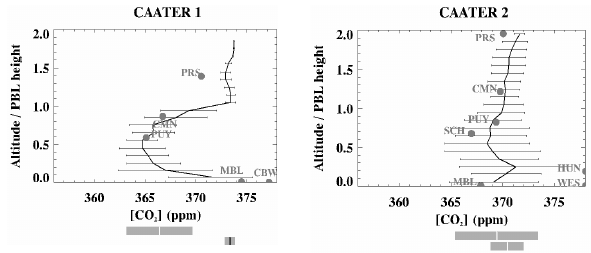
Fig. 11. Variability observed in the PBL and the FT during each campaigns (left: CAATER 1, right: CAATER 2) using profiles only. The altitude of each individual profile has been normalized to the relevant PBL height. The plot shows the mean and standard devi- ation (1- σ) of CO 2 concentration over layer of 1/10th of the PBL height. The global mean and variability ( ± 1- σ standard deviation) in the PBL (upper grey bar) and FT (lower grey bar) are shown ac- cording to the CO 2 concentration scale of the